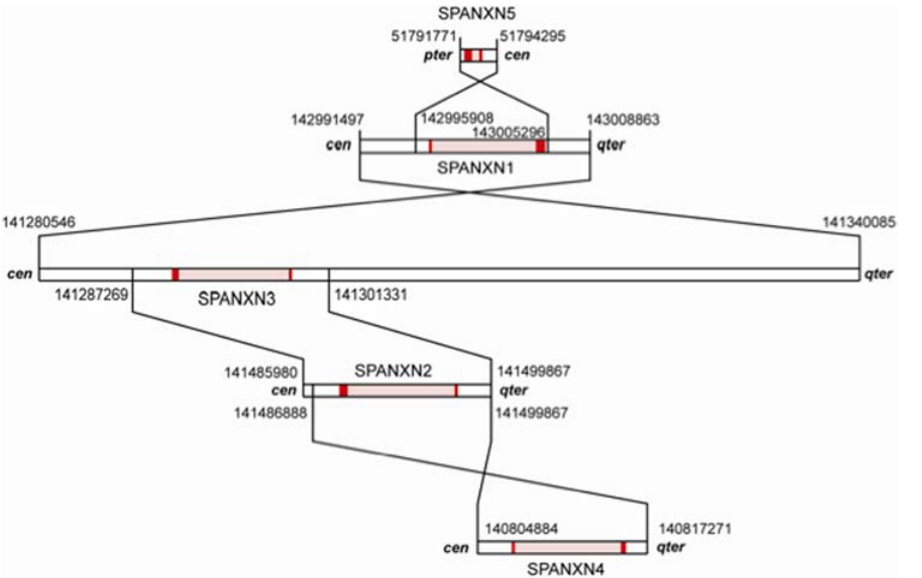
Figure 2. Evolution of SPANX-N genes. The probable scheme of evolution of the SPANX-N gene family is based on the pairwise alignments and breakpoint analysis. The exons are marked red in colour, intron regions are marked in pink. Positions relative to the centromere (cen) and telomere (qter) are shown. The numbers near duplication breakpoints indicate positions of the SPANX-N regions in the human genome (hg16; UCSC March 2006 genome version). The most likely scenario is that SPANX-N3 was the original locus.